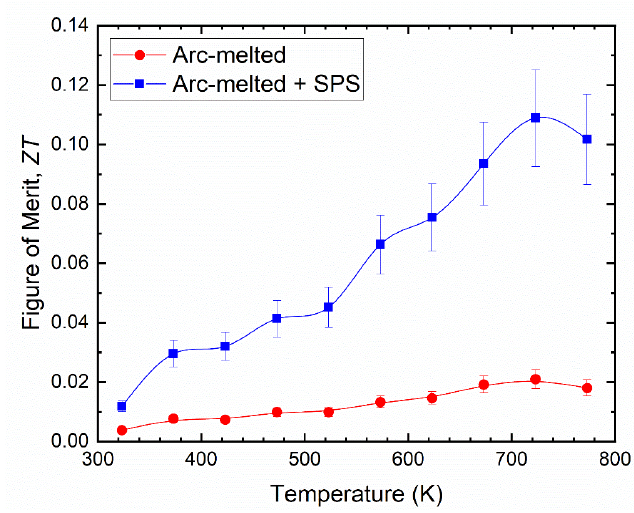
Figure 10. Temperature dependence of the thermoelectric figure of merit, ZT .